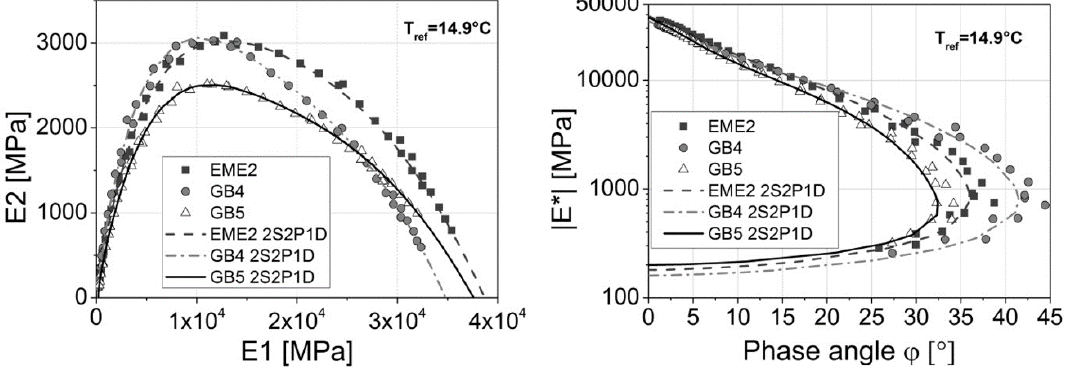
Figure 9. Cole-Cole (left) and Black (right) diagrams curves for each